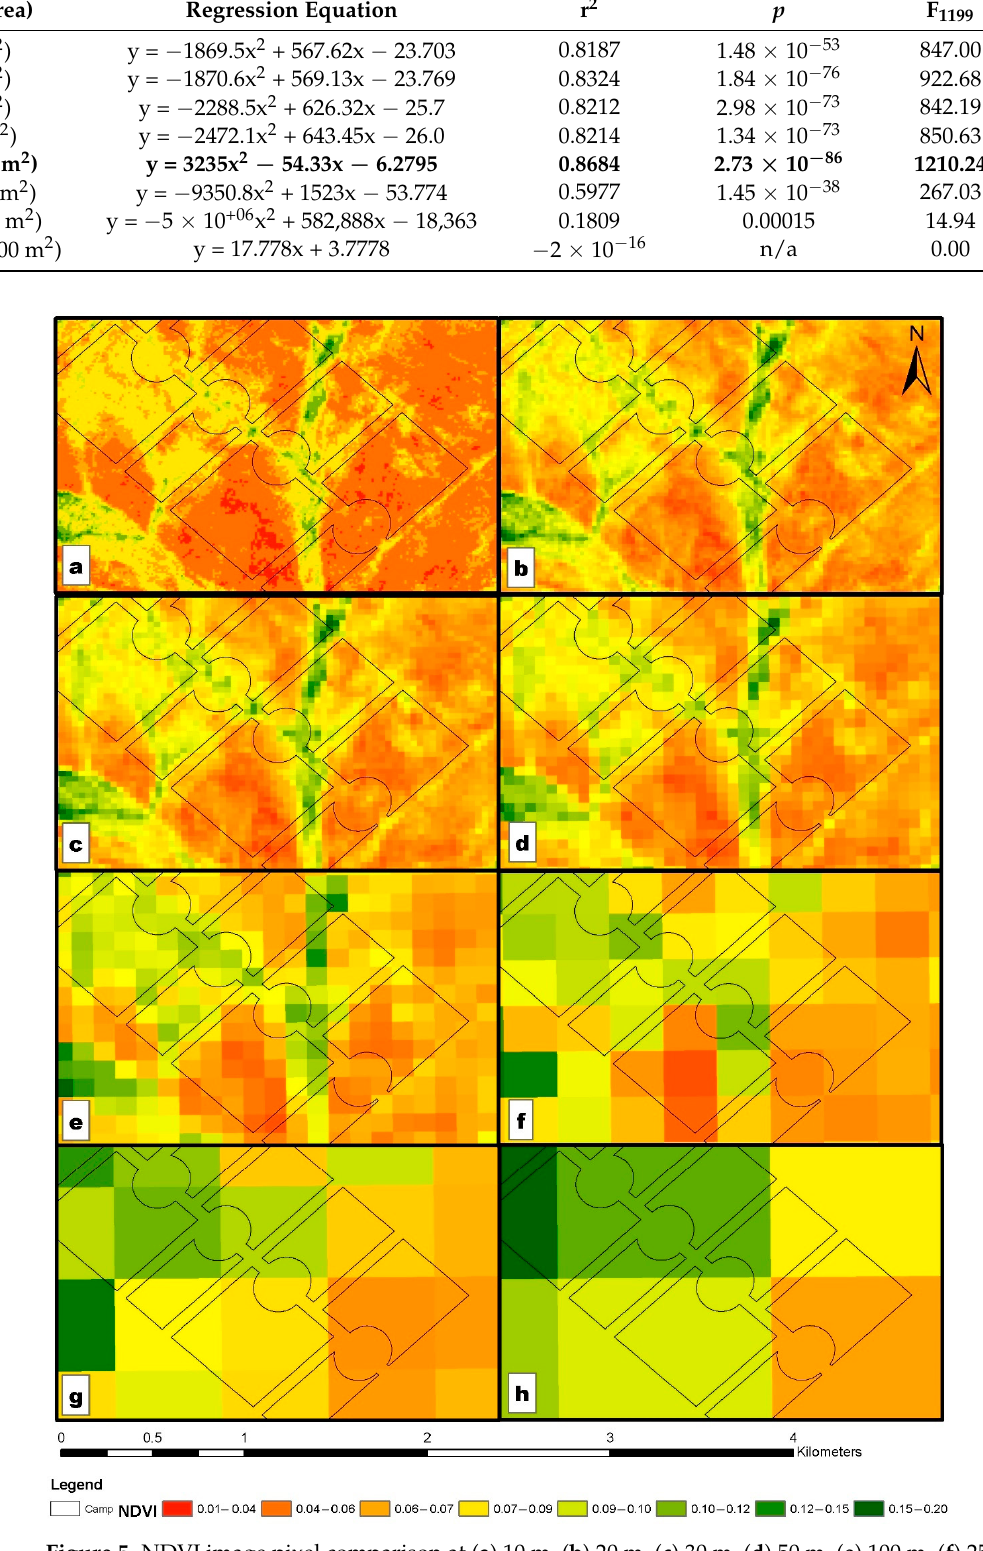
Figure 5. NDVI image pixel comparison at ( a ) 10 m, ( b ) 20 m, ( c ) 30 m, ( d ) 50 m, ( e ) 100 m, ( f ) 250 m, ( g ) 500 m and ( h ) 1000 m of the grazing stocking rate trial.